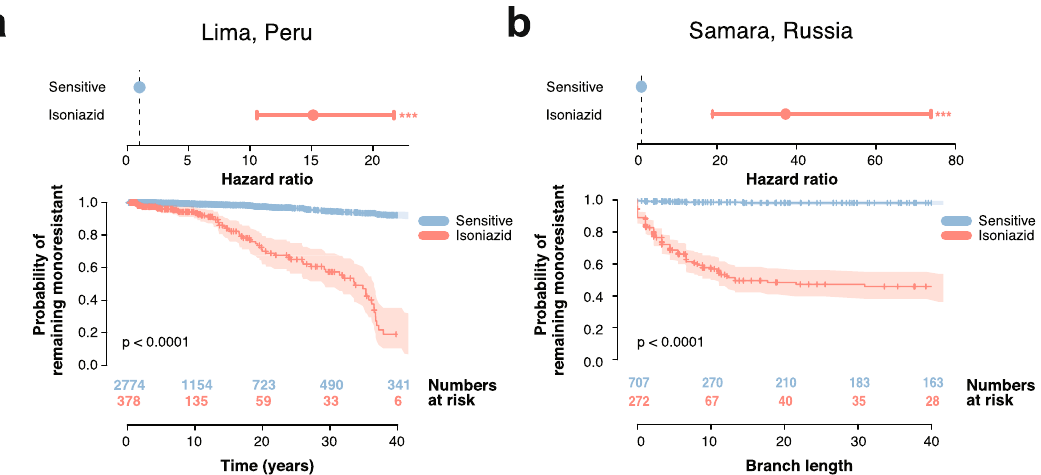
Fig. 6 Hazard ratio and Kaplan – Meier curve for rifampicin acquisition. a , b Top: Hazard ratio (HR). Points and error bars represent the HR estimate and the 95% CI, respectively. The p -value for the HR was calculated using the likelihood ratio test. Bottom: Kaplan – Meier curve and numbers at risk. Y-axis represents the probability of remaining susceptible to rifampicin, while the X-axis shows the time in years or the distance in branch length. Shaded areas show the 95% con fi dence interval. P -values for the Kaplan – Meier curves were calculated using the log-rank test. a Depicts the risk of acquiring rifampicin resistance from an already isoniazid mono-resistant background compared to a drug susceptible one (HR 15.12, 95% CI 10.54 – 21.69, Likelihood ratio test p -value = 1.3 × 10 − 40 ) and the Kaplan – Meier curves for the different backgrounds (Log-rank test p -value = 2.7 × 10 − 63 ). b Same metrics for the Samara dataset (HR 37.28, 95% CI 18.81 – 73.88, Likelihood ratio test p -value = 3.4 × 10 − 25 ; Kaplan – Meier curve p -value = 4.6 × 10 − 63 ). Statistical signi fi cance of the hazard ratio differences presented next to the CI bars (* p < 0.05; ** p < 0.01; *** p < 0.001).